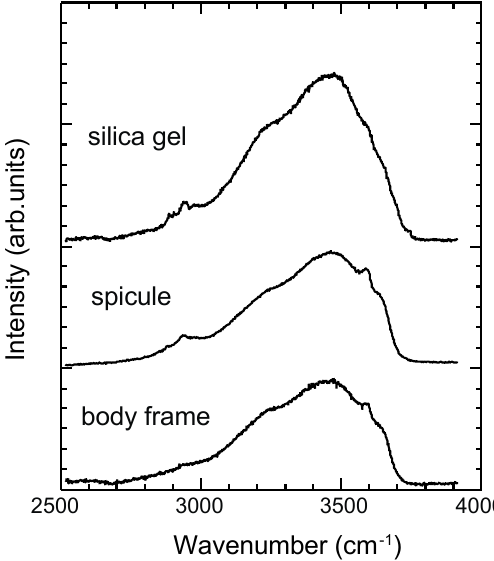
Figure 7. Raman spectra ( ν = 2500–3900 cm − 1 ) for body frame, spicule and silica gel. The spectrum of silica glass had no peaks in this wavenumber region.